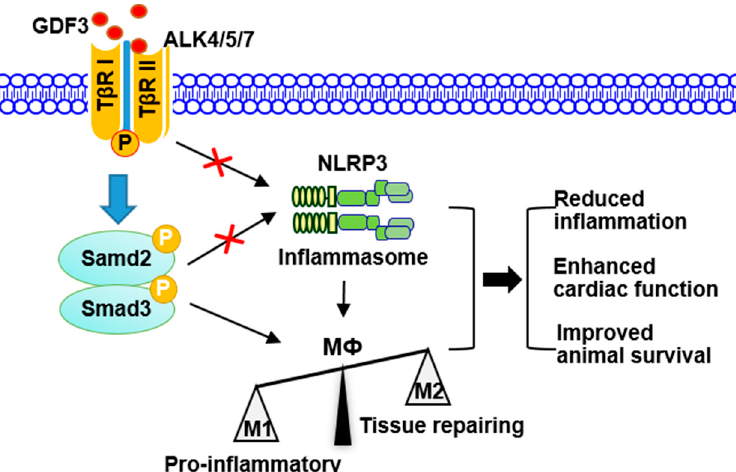
Figure 8. Scheme depicting GDF3-drived protection against endotoxin-induced inflammation, cardiac dysfunction and mortality. Exogenous GDF3 binds to ALK4 / 5 / 7 where activates Smad2 / 3 and inhibits NLRP3 inflammasome, consequently suppresses macrophage pro-inflammatory phenotype (M1), leading to reduced inflammation, cardiac dysfunction, and mortality in endotoxin-induced septic mice.